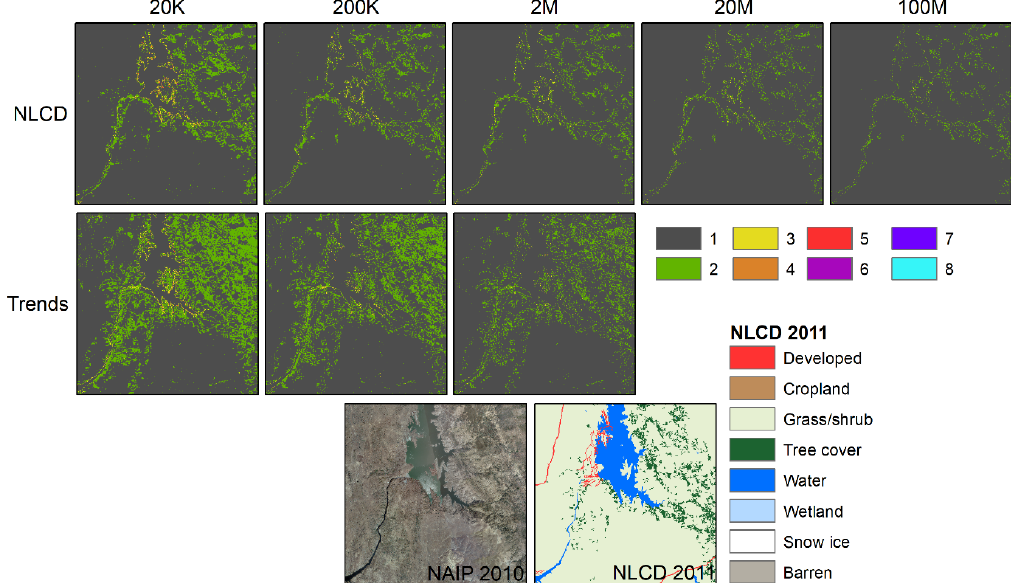
Figure 4. The top row shows the consistency map from National Land Cover Database (NLCD) 2001–based 2010 land cover results, which were derived from eight iterations with up to 100M training data samples. The second row shows the consistency from Trends-based 2010 land cover results with up to 2M training samples (18 km × 18 km, Lake McClure, California. 37 ◦ 35 ’ 39.04” N , 120 ◦ 15 ’ 44.65” W ). The bottom row shows the location in a high-resolution image [37] and NLCD 2011